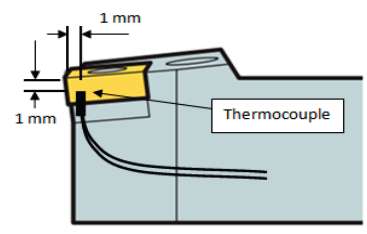
Figure 7. Position of thermocouple.